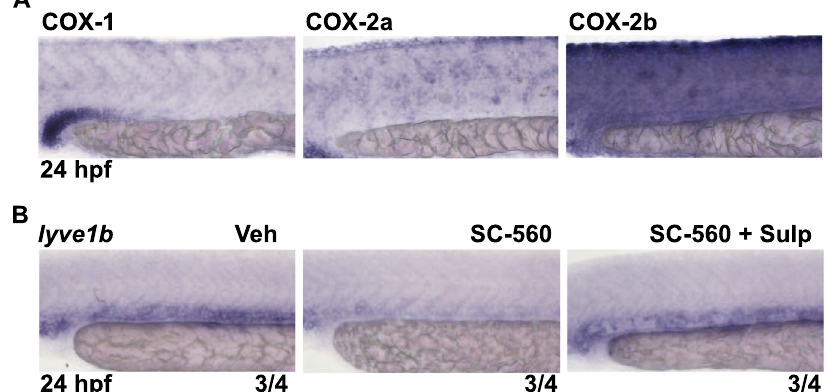
Figure 5. COX1-derived PGE 2 is involved in the lymphatic specification. ( A ) Expression of COX1, COX2a, and COX2b was analyzed by WISH at 24 hpf. ( B ) Zebrafish embryos were treated with Veh or SC-560 (25 μ M) in the absence or presence of Sulp (10 μ M) from 0 to 24 hpf, and the expression of lyve1b was analyzed by WISH at 24 hpf. The number at the bottom right of each panel indicates the number of embryos demonstrating the phenotype shown in the panel over the total number of embryos analyzed in a representative